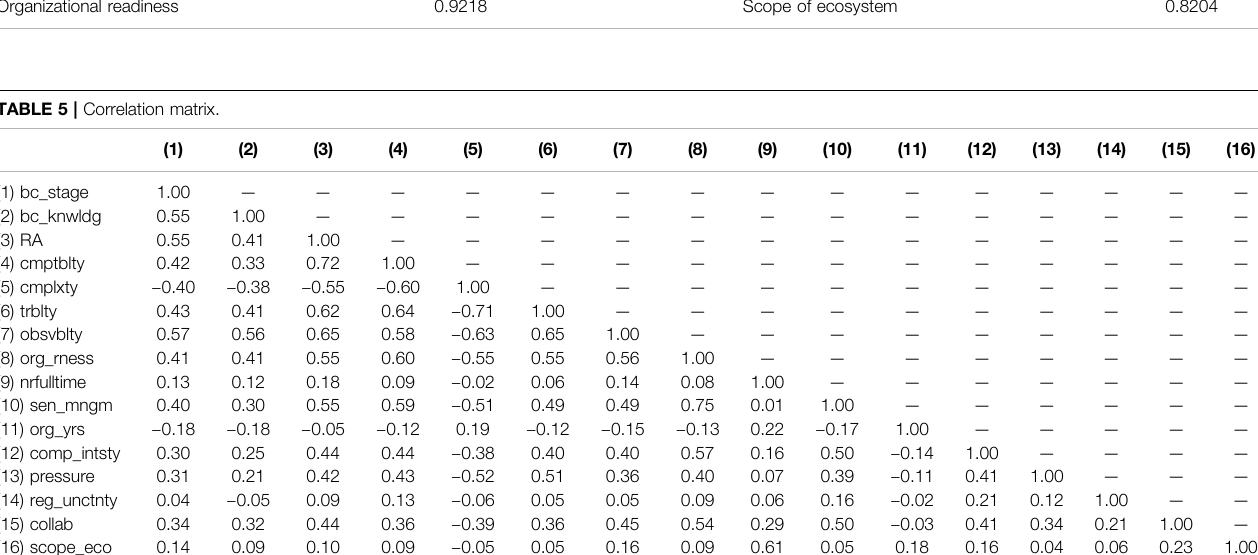
TABLE 5 | Correlation